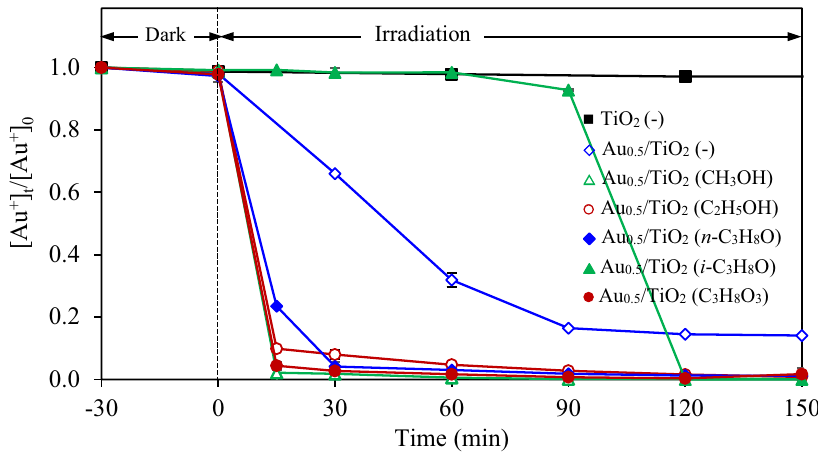
Figure 11. Variation of gold recovery via Au 0.5 /TiO 2 photocatalyst at dosage of 2 g/L and light intensity of 3.20 mW/cm 2 in the presence of different alcohols as the hole